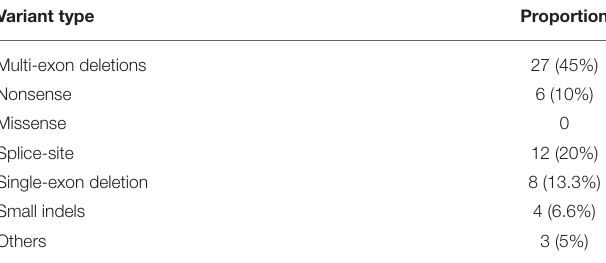
TABLE 3 | Genetic variants identified in 60 patients with DOCK8